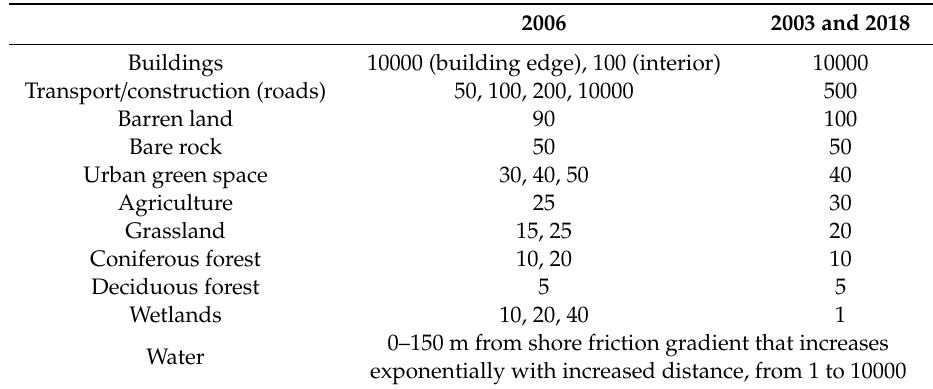
Table 1. Friction values per land-cover type for cost surfaces from Mörtberg et al. [66] and for the 2003 and 2018 classifications in the present